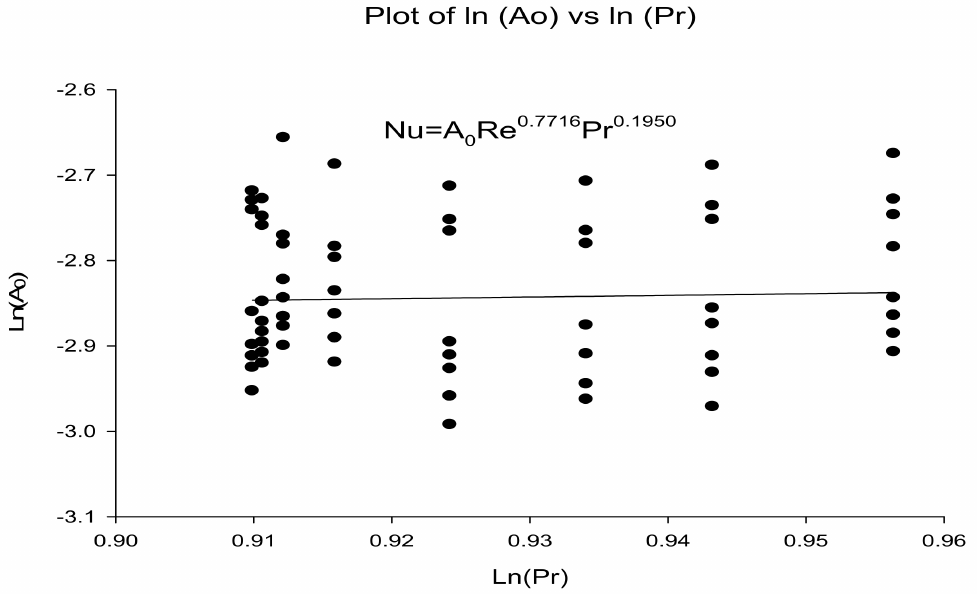
Figure 4. Experimental results of coefficient Ao and Prandtl